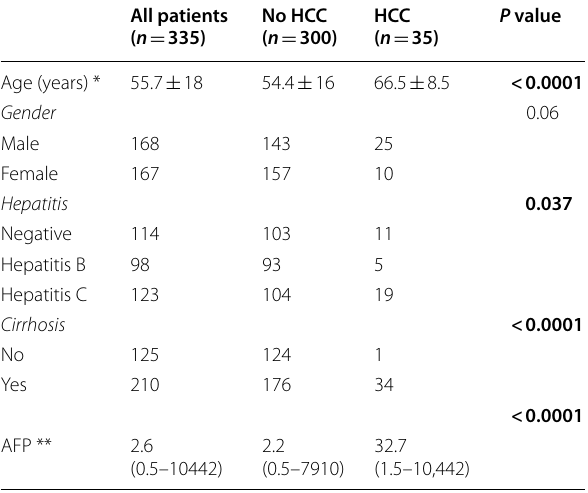
Table 1 Baselines characteristics of study